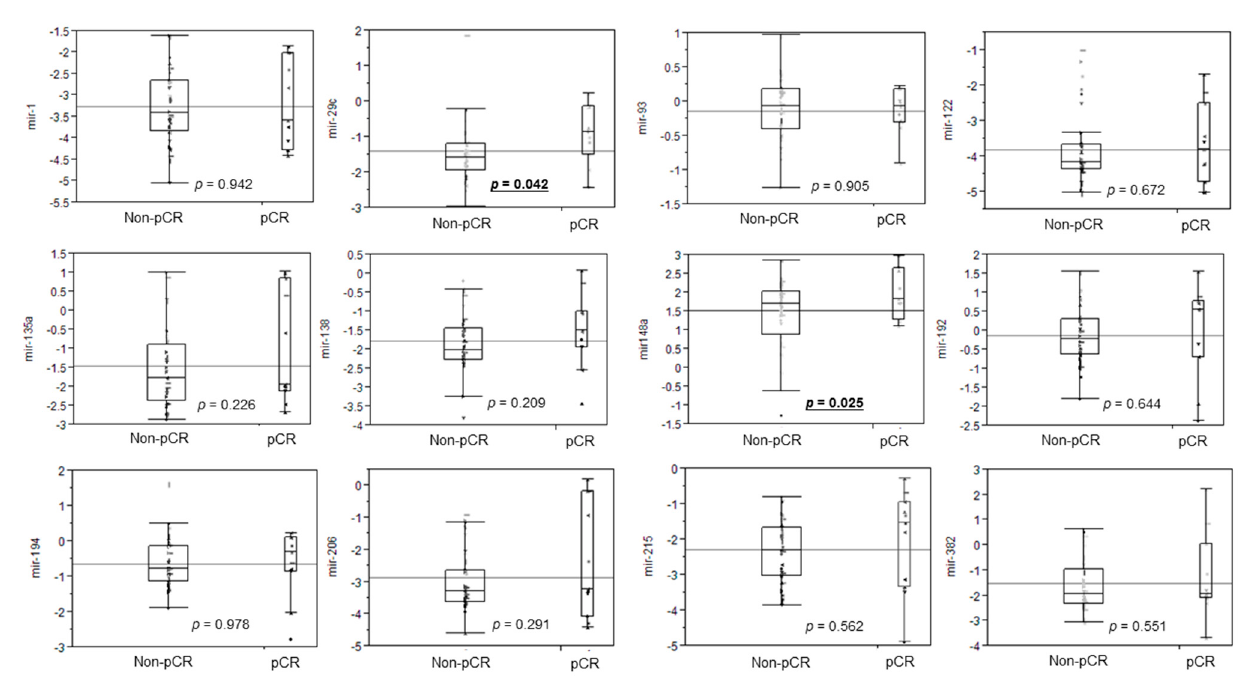
Figure 2. Tissue microRNA (miRNA) levels in 51 patients. To identify clear differences in tissue miRNA levels between the pCR and non-pCR groups, we enrolled 11 patients with a pCR and 40 without a pCR. The dot plots represent 12 miRNA levels quantified by TaqMan real-time polymerase chain reaction (PCR) and normalized to internal controls: U6 level using the 2 − ∆∆ Ct method and stratified by pathological response to neoadjuvant chemoradiotherapy. The horizontal bars represent the medians and 95% confidence intervals. pCR: pathological complete response.